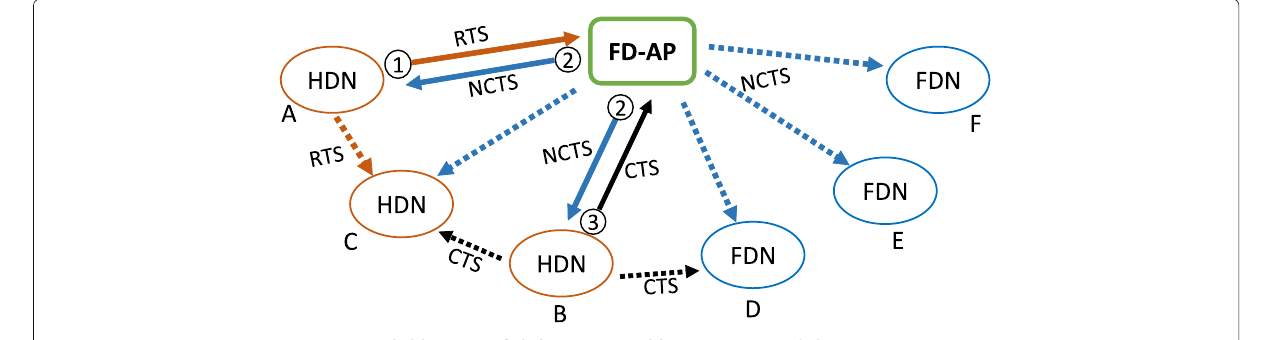
For example, AP sends an RTSD with a DI value of 11 to an FDN. The corresponding FDN also sends a CTSD with a DI value of 11 because the FDN has data for AP. BFD transmission then